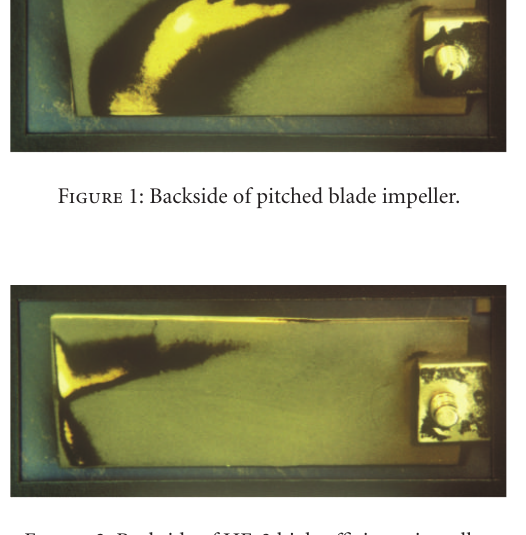
Figure 2: Backside of HE-3 high-e ffi ciency impeller.